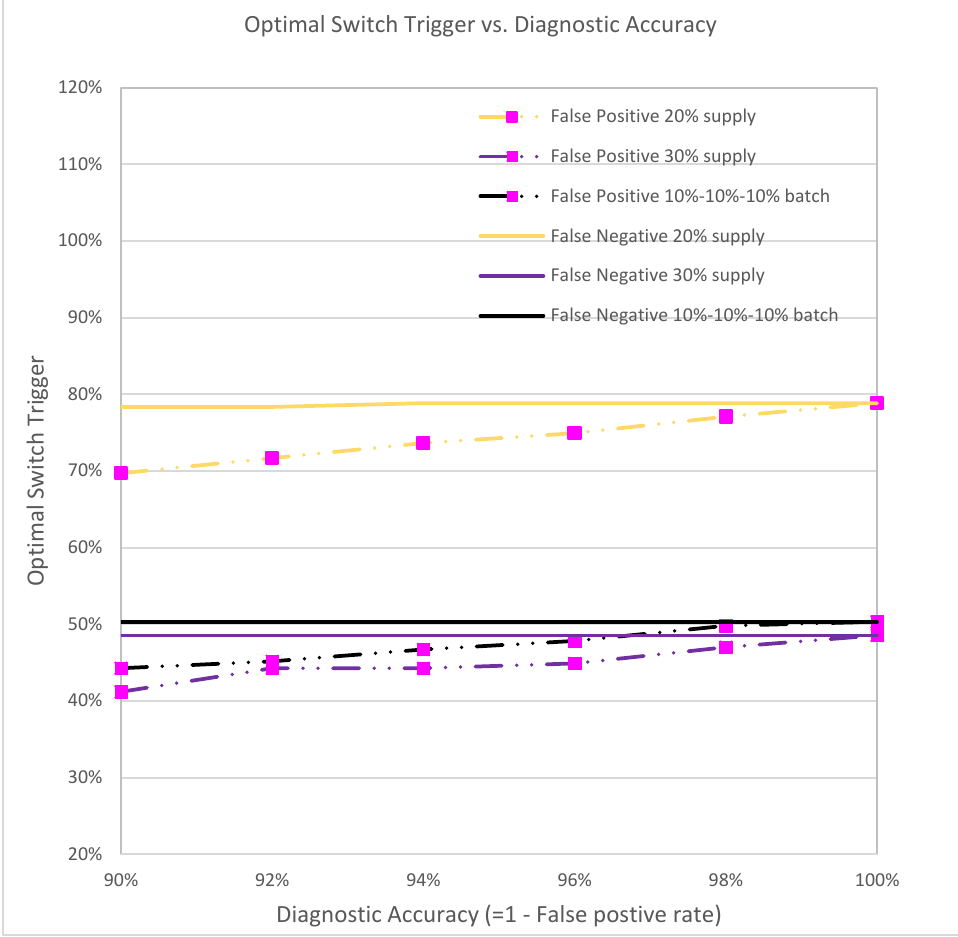
Figure 11. The optimal switch trigger under different diagnostic accuracy rates.